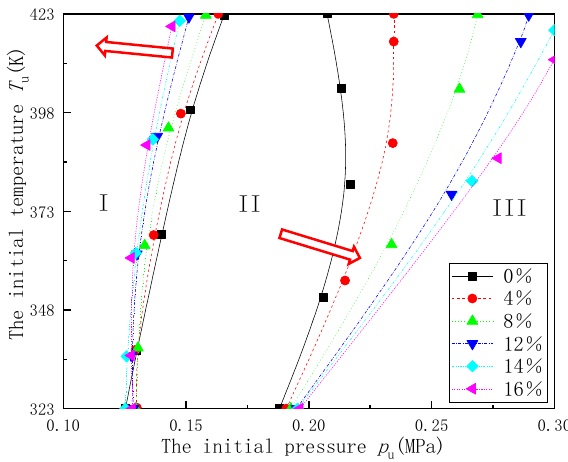
Figure 9. Variation pattern of the equal weight curve corresponding to DR with ∆T = 25 K and ∆P = 0.05 MPa.